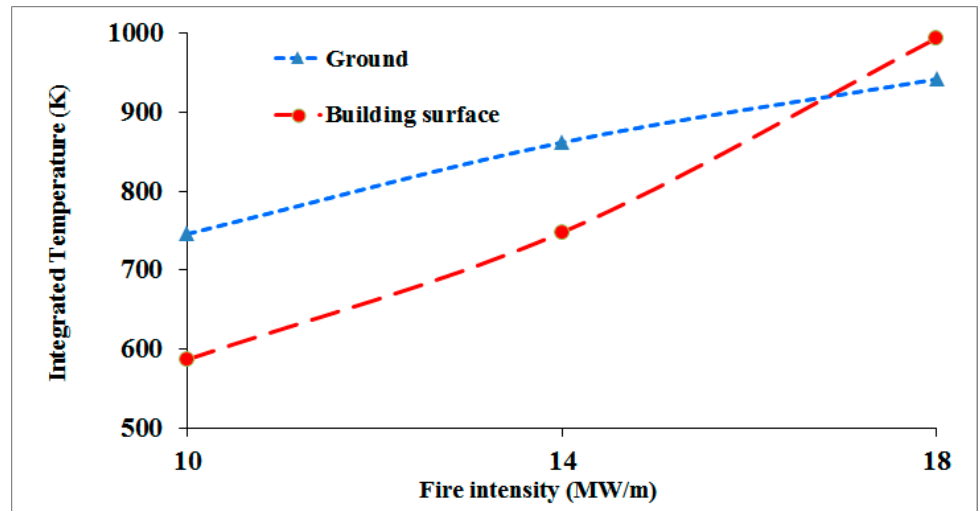
Figure 8. Integrated temperature on the ground at the considered domain and surface building for a constant U ref = 6 m/s and fire intensities 10, 14 and 18 MW/m.